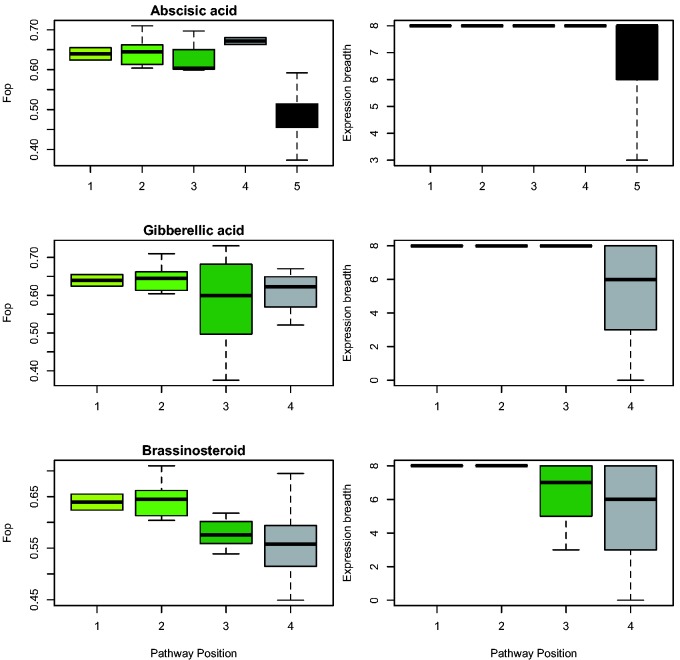
Relationship between codon bias (Fop) and expression breadth with pathway position for P. abies in three of the four branches of the terpenoid synthesis. Plant terpenoid simplified pathway showing the pathway positions of each of the branches can be found in supplementary figure S7, Supplementary Material online.